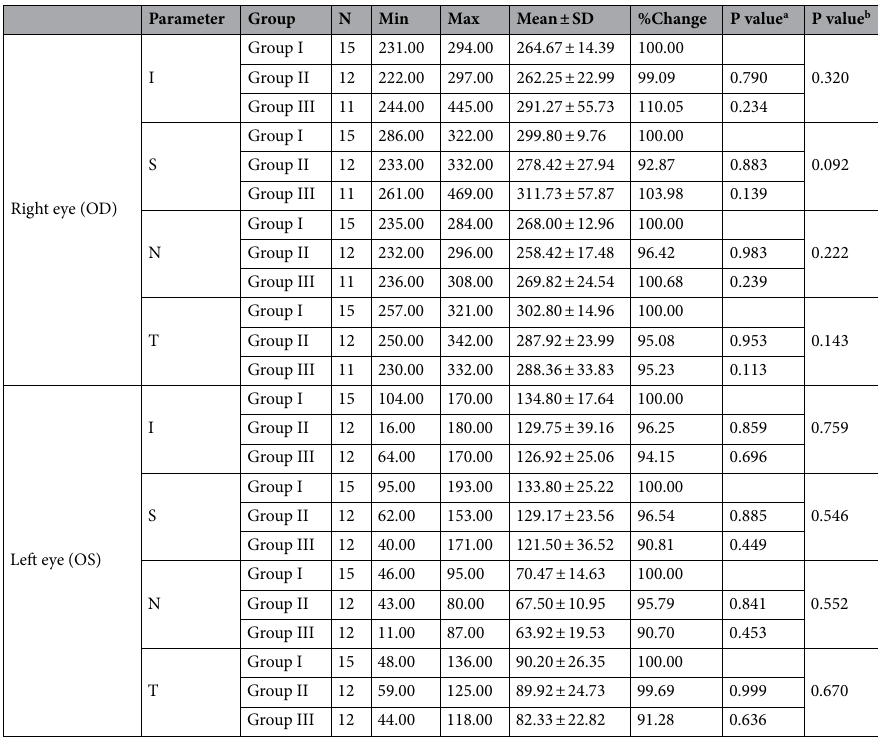
Table 4. Optic nerve (RNFLT) (µm) in right eye (OD); left eye (OS) of controlled diabetic patients with and without retinopathy compared to healthy control subjects. Comparisons done using one-way ANOVA test between all groups with multiple comparisons (Dunnett test) to compare each group with the control group in all parameters. a P value between each group and the control group . b P value between all groups.